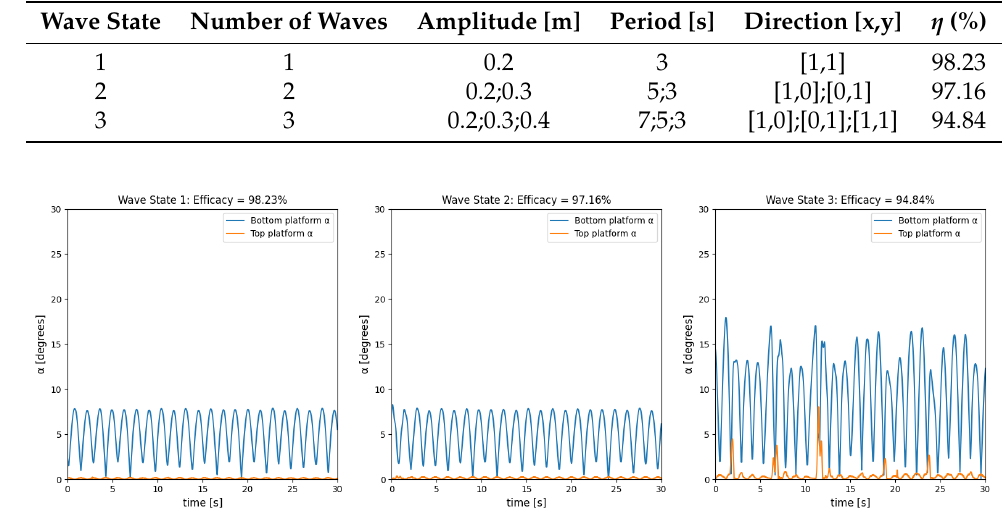
Figure 12. Resulting plots for the different wave states presented in Table